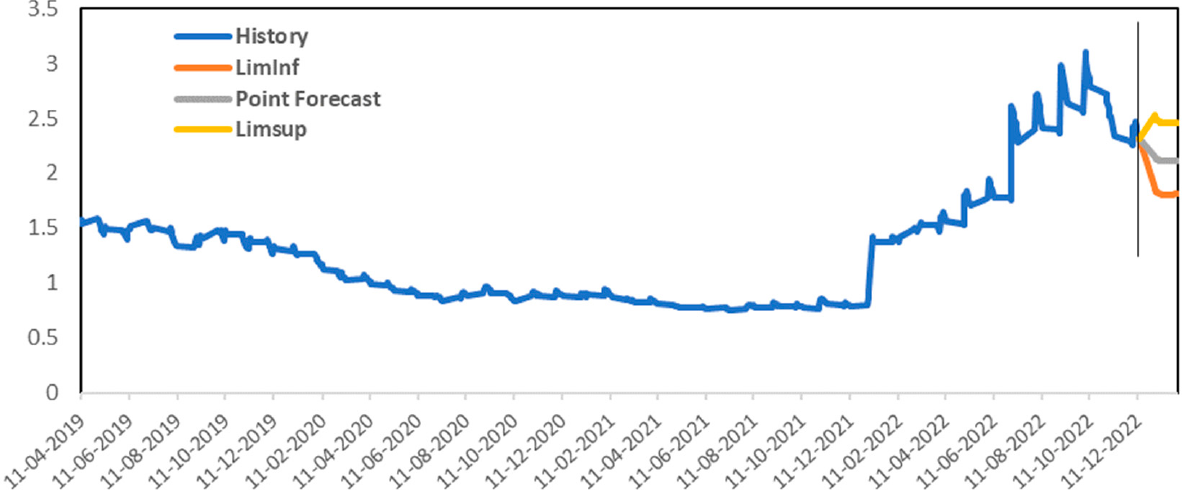
Figure 3. Out-of-Sample Forecast: Scenario 1, Volatility: Nickel/Confidence Intervals 95% (where LimInf and Limsup are lower and upper confidence limits).